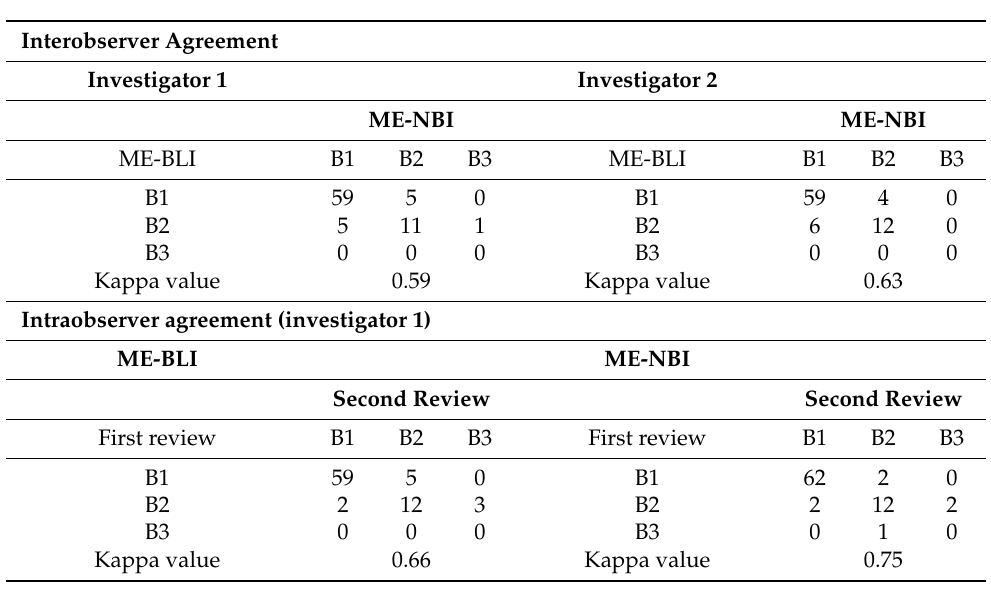
Table 4. Interobserver and intraobserver agreements for diagnosing the invasion depth of SESCC by the JES’s IPCL